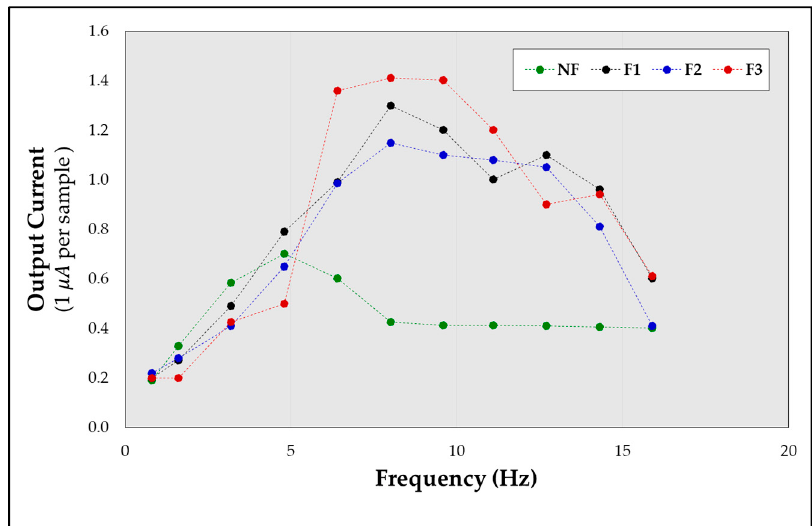
Figure 12. Output current corresponding to frequency variations of IPMC specimens, prepared according to the foaming conditions for Nafion.